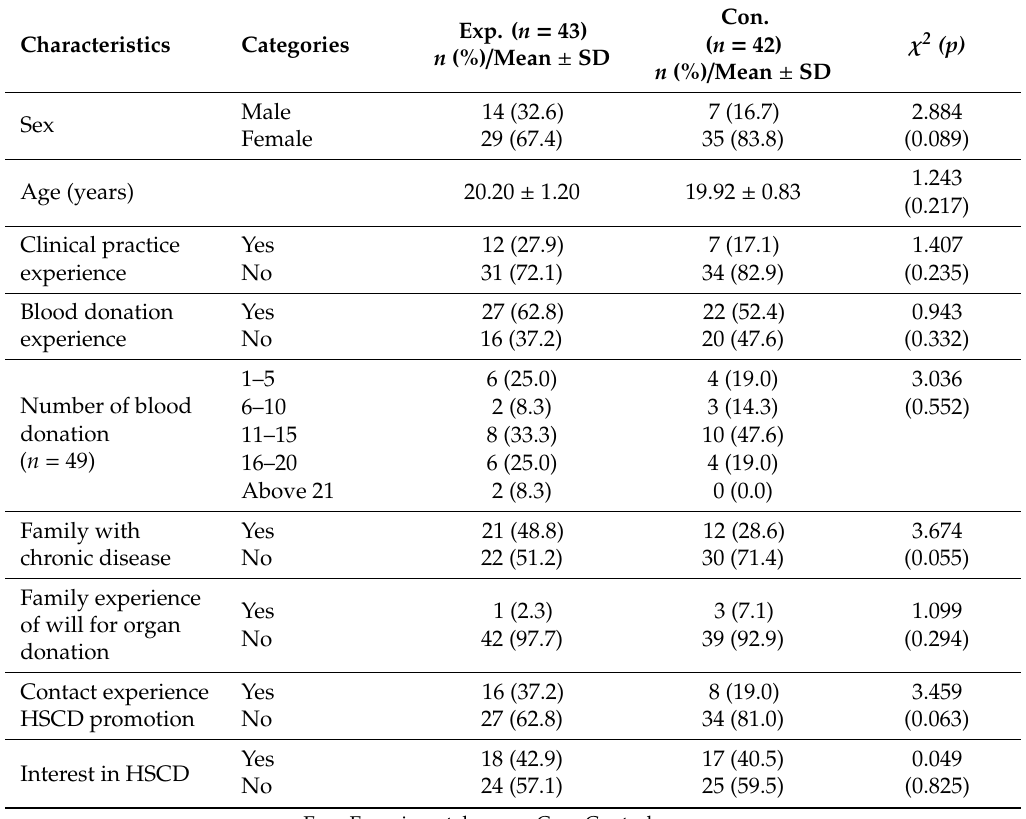
Table 2. Homogeneity test of the two groups on general characteristics.